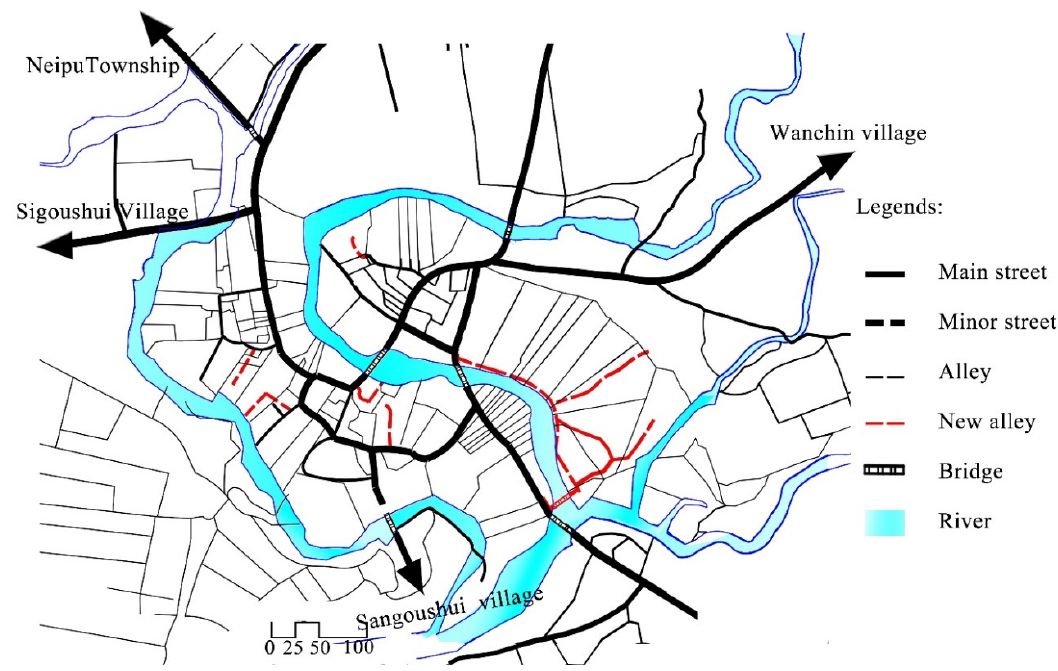
Figure 5. Road System of the Wugoushui Settlement.